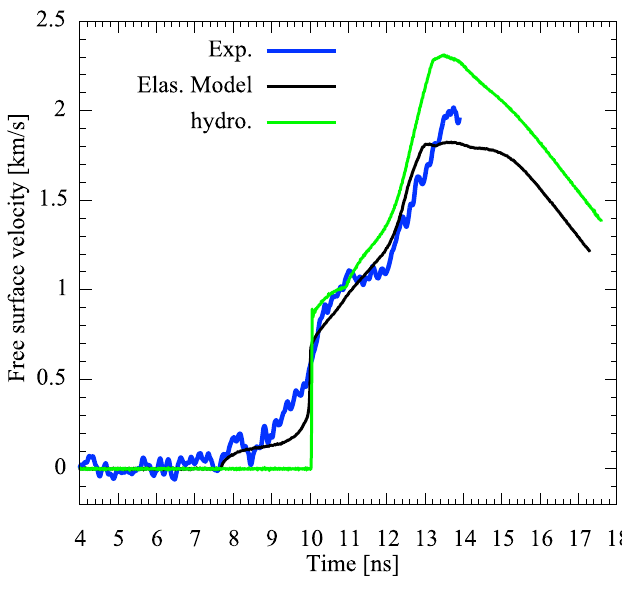
Figure 4. Comparison between experiment ( blue curve) and simulations with ( black curve) and without ( green curve) material strength model. for a target of 50 µ m thickness at a loading rate of 3.11 × 10 7 s − 1 . Similar behaviour was observed for the 25 µ m target and other loading